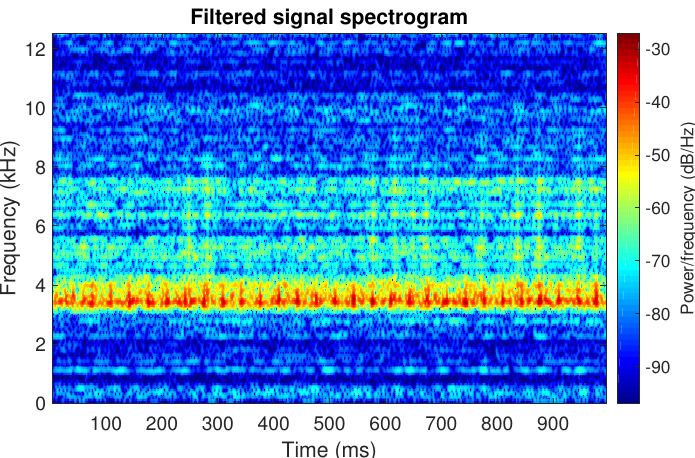
Figure 17. Spectrogram of filtered signal s 2 by CVB selector.